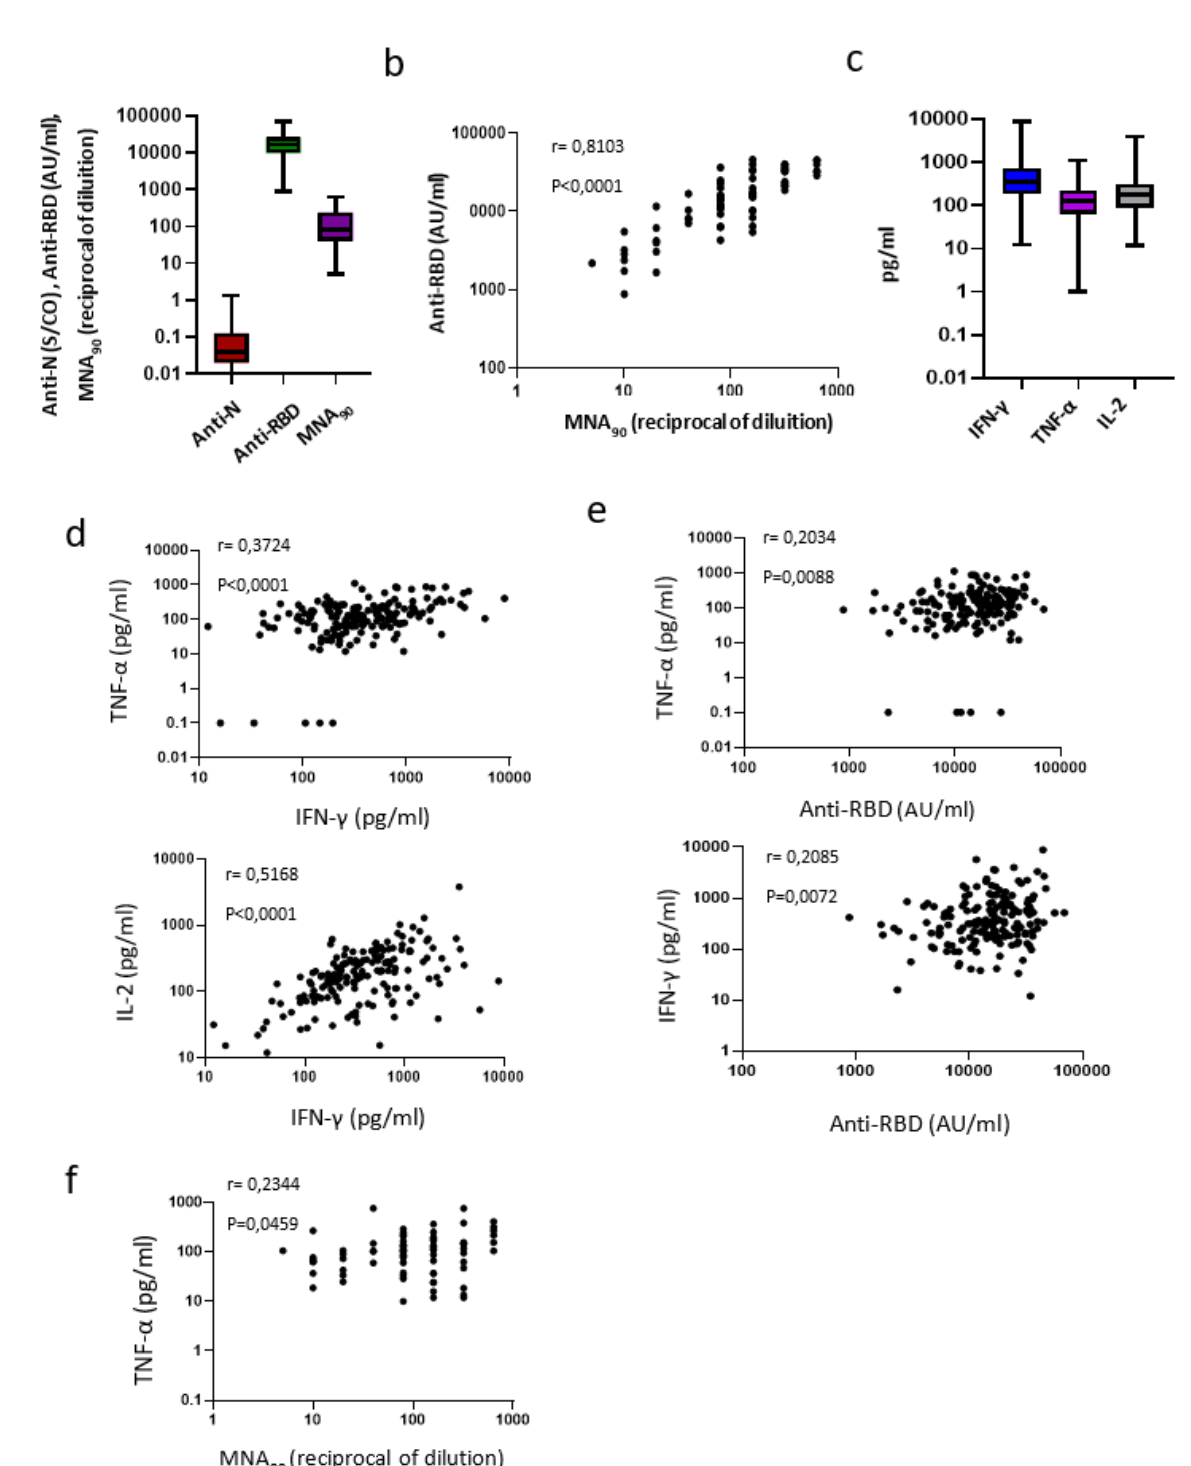
Figure 2. Coordinated immune response to vaccination. Legend to Figure 2: Cross-sectional study ( a – f ). ( a ) SARS-CoV-2 specific anti-N and anti-RBD Abs were analyzed at T2 in 169 HCWs; a microneutralization assay (MNA 90 ) was also performed in a subgroup of the enrolled HVWs ( n = 73). Results are shown as box and whiskers graphs. ( b ) The correlation between the anti-RBD antibody titer and MNA 90 is shown ( n = 73); ( c ) Cytokines (IFN- γ , TNF- α , IL-2) were quantified in stimulated blood samples at T2 ( n = 169); ( d ) The correlation between the levels of IFN- γ and TNF- α and between IFN- γ and IL-2 are shown ( n = 169). Each black dot represents one sample ( e ) The correlations between the level of IFN- γ and anti-RBD antibody titers and between the level of TNF- α and anti -RBD antibody titers are shown ( n = 169). Each black dot represents one sample ( f ) The correlation between TNF- α and MNA 90 is shown ( n = 73). Each black dot represents one sample.